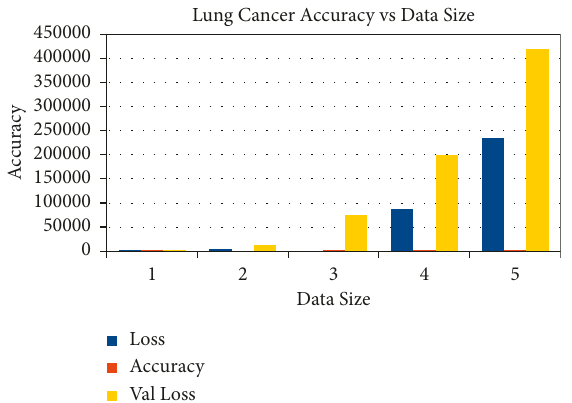
Figure 3: Graph showing lung cancer accuracy prediction by using blockchain materials